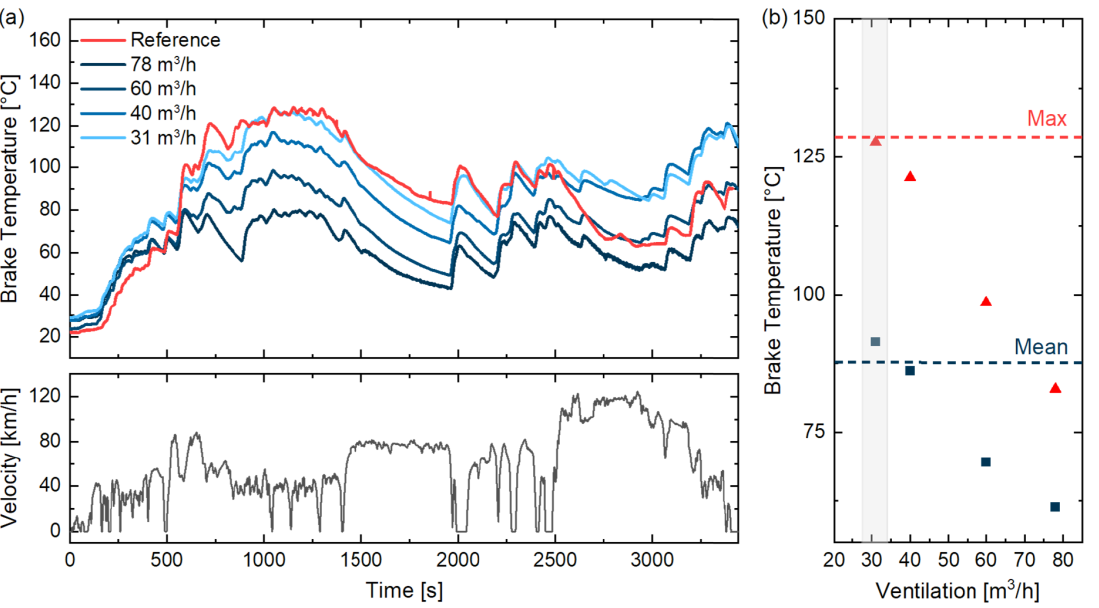
Figure 2. ( a ) Brake temperatures for the on-road reference test without brake housing (red) and the tests using the chassis dynamometer with brake housing (blue colors) at different air flows. ( b ) Maximum and average brake temperature of the reference run (lines) and the dynamometer tests according the set ventilation level.